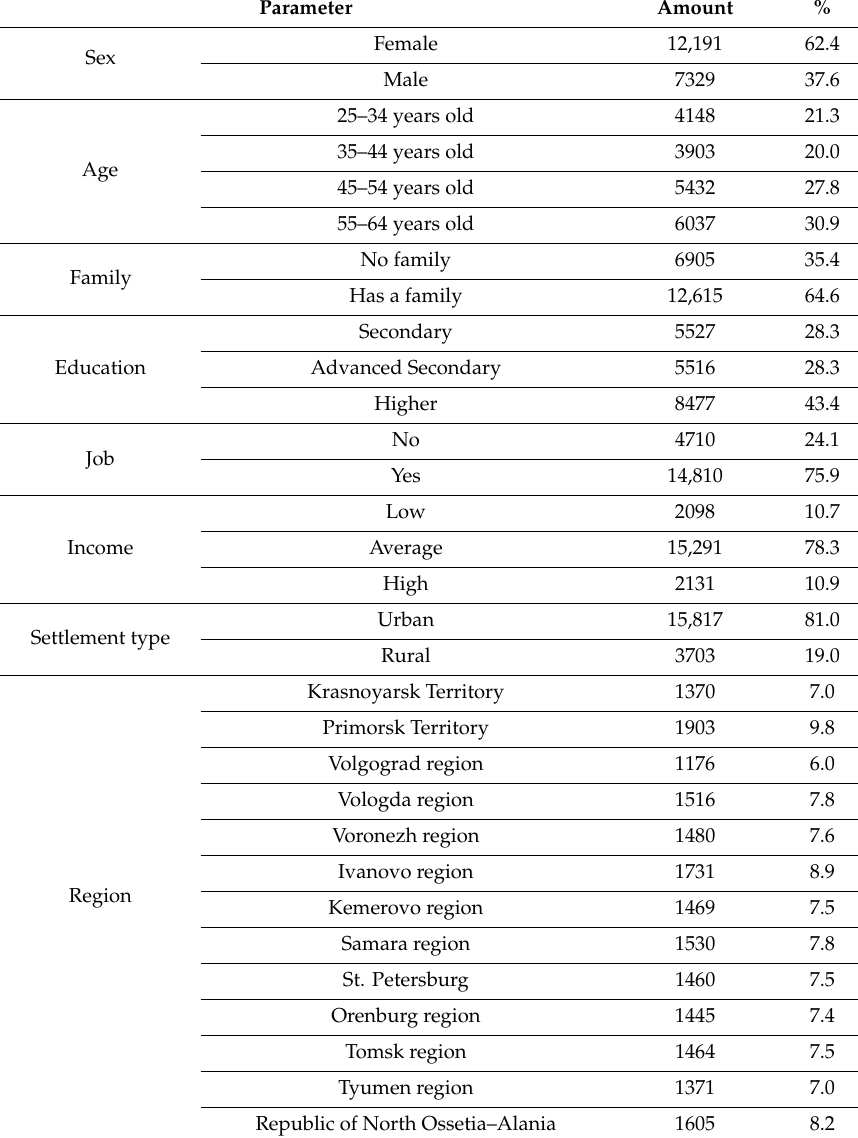
Table 1. Baseline characteristics of the study